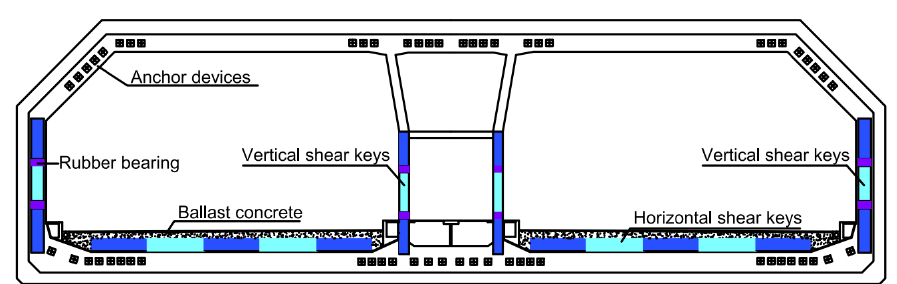
Figure 1. Shear keys in the immersion joint